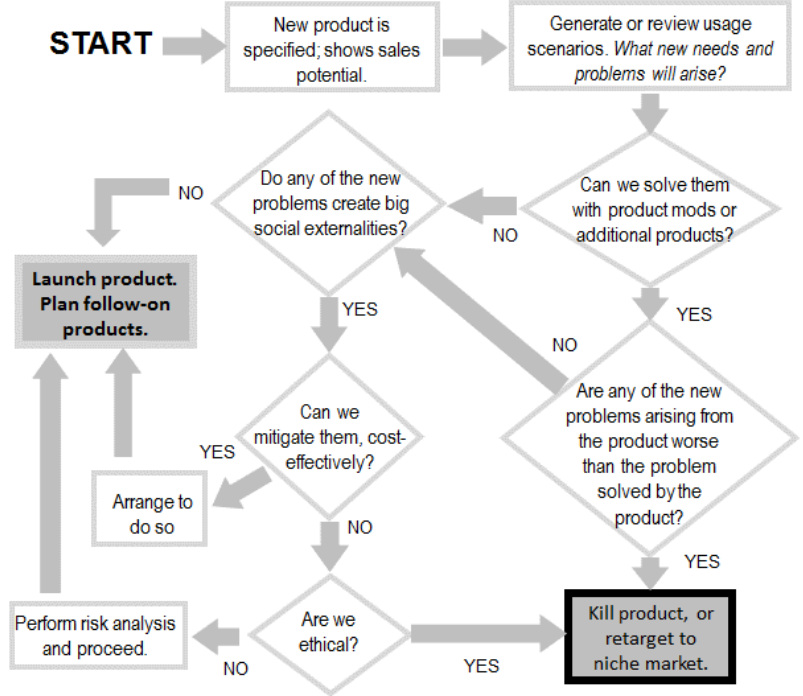
Fig. 2 . Guide for planning sustainable innovative